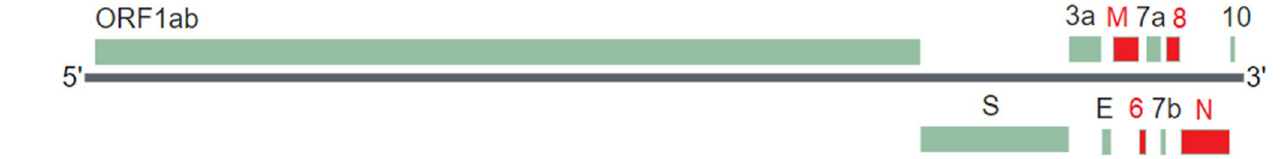
Figure 1. Protein coding genes of SARS-CoV-2, which consist of 7 nonstructural genes (ORF1ab, ORF3a, ORF6, ORF7a, ORF7b, ORF8 and ORF10) and 4 structural genes (S, E, M, and N). ORF1ab polyprotein is coded by gene ORF1ab at locations 266–21555 (based on the reference genome sequence NC_045512), surface glycoprotein coded by gene S at locations 21563–25384, ORF3a protein by gene ORF3a (25393–26220), envelope protein by gene E (26245–26472), membrane glycoprotein by gene M (26523–27191), ORF6 protein by gene ORF6 (27202–27387), ORF7a protein by gene ORF7a (27394–27759), ORF7b protein by gene ORF7b (27756–27887), ORF8 protein by gene ORF8 (27894-28259), nucleocapsid phosphoprotein by gene N (28274- 29533), and ORF10 protein by gene ORF10